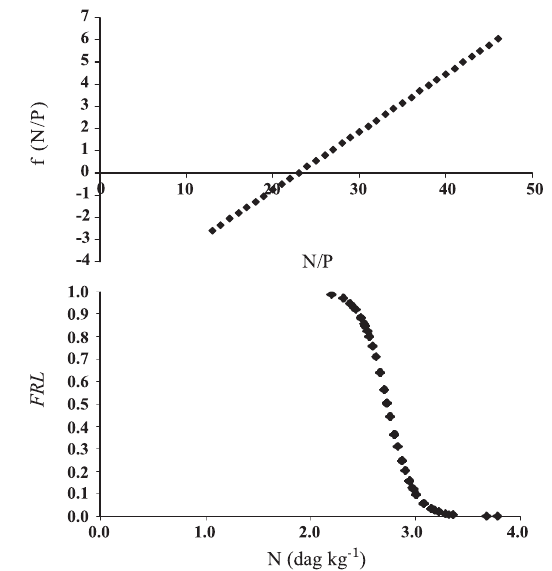
Figure 1. linear relationship between n/p and f(n/p) and non-linear relationship between n and FRL , for mean and standard deviation of n/p of 22.93 and 3.83, respectively, and 2.73 and 0.21 dag kg -1 for